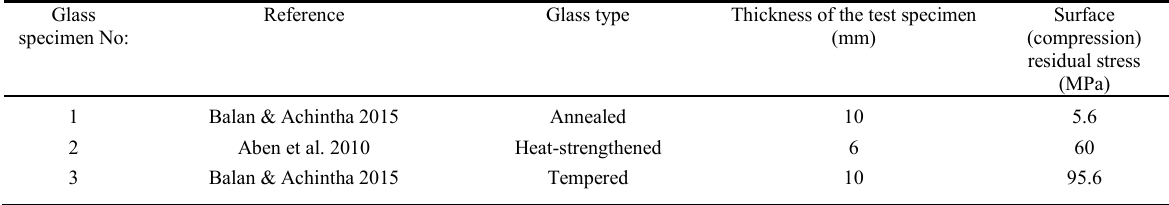
Table 1: Surface residual stress values of three glass test